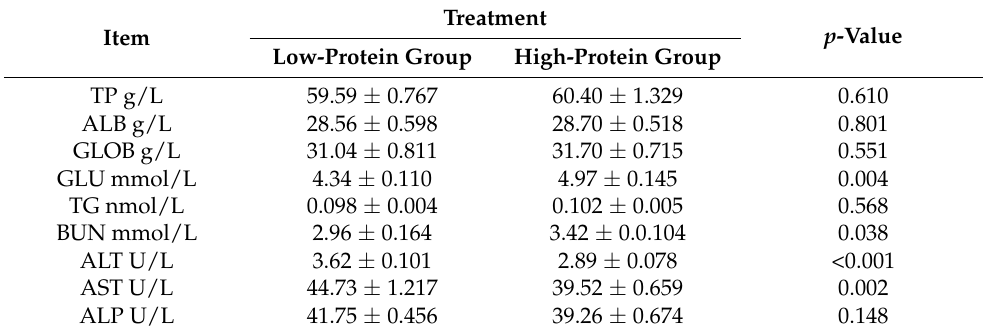
Table 4. Effects of the dietary protein level on the plasma biochemical indexes of growing